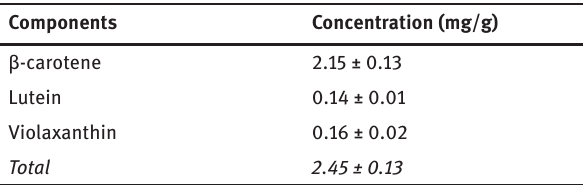
Table 2: Carotenoid contents in the UM obtained from T. chuii wet